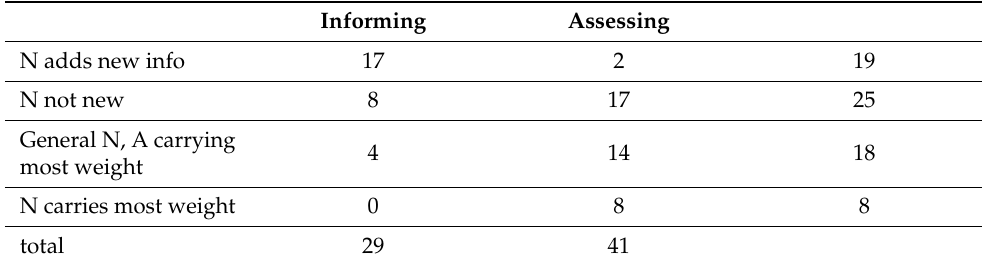
Table 4. The role of the N in the